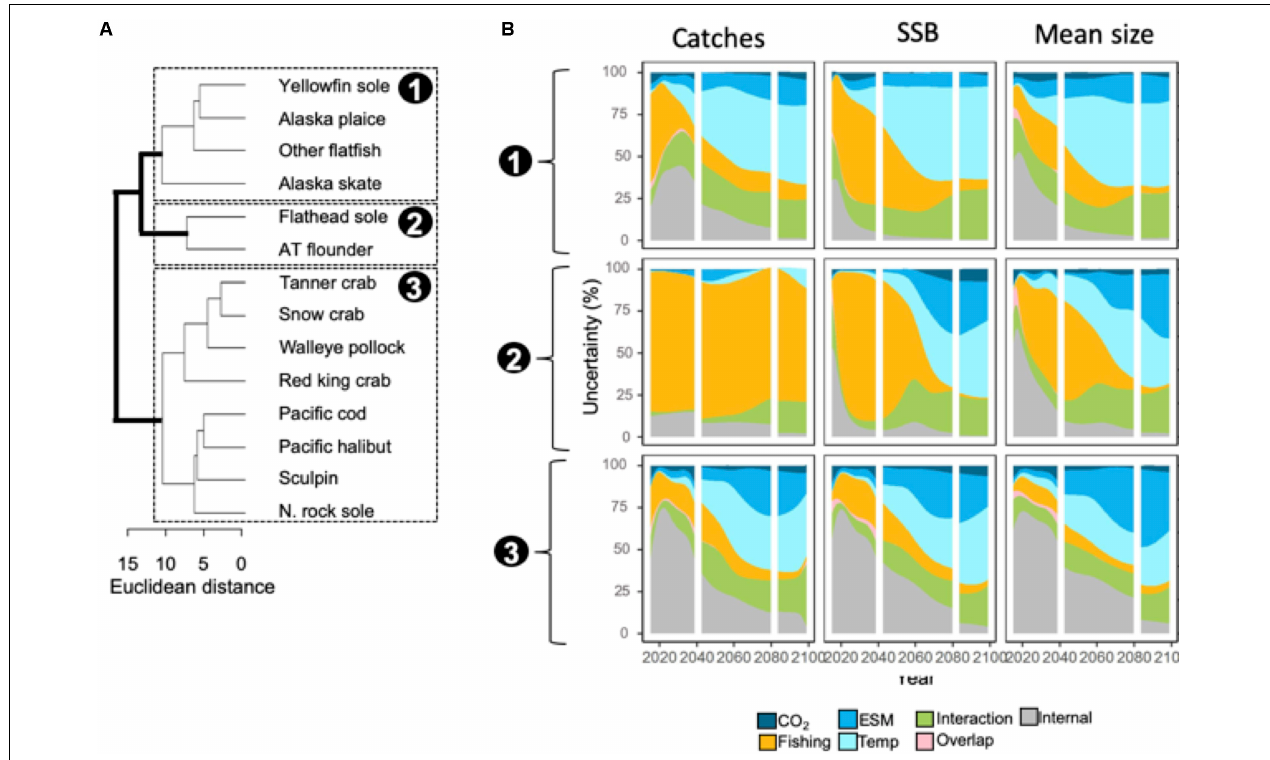
FIGURE 3 | (A) Dendrogram of species similarity (Euclidean distance) based on relative importance of different uncertainty sources to catches, SSB, and mean weight ensemble projections. Three clusters were identified (labeled 1–3). (B) Area plots indicate the proportion of uncertainty associated with each source averaged across species within the three clusters. Species name abbreviations in panel (B) : N. Northern; AT,